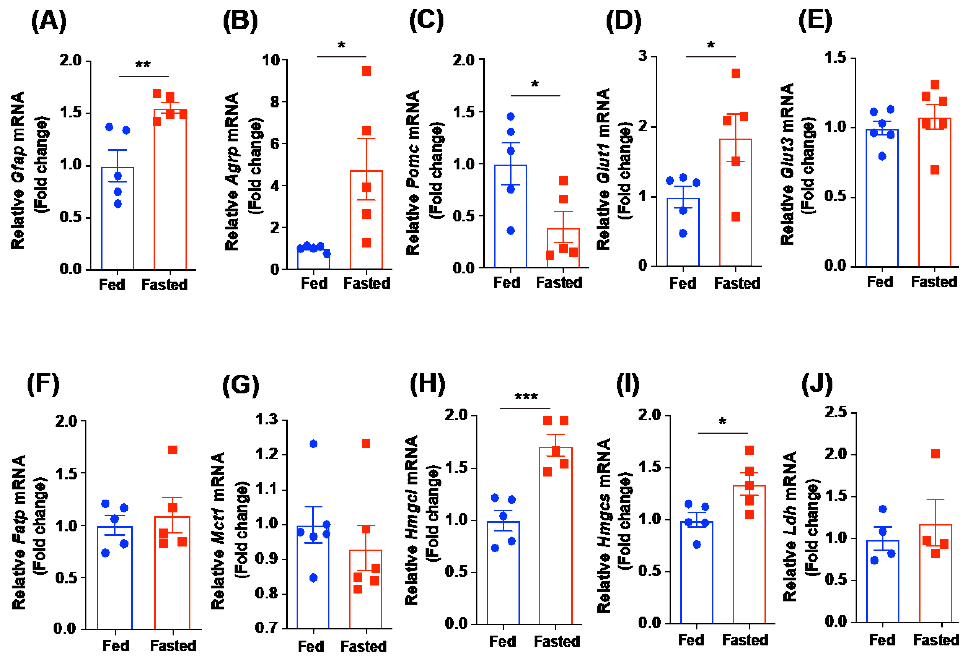
Figure 3. Altered mRNA levels of genes involved in metabolic processes in the hypothalamus in response to short-term food deprivation. qPCR experiments were performed with the